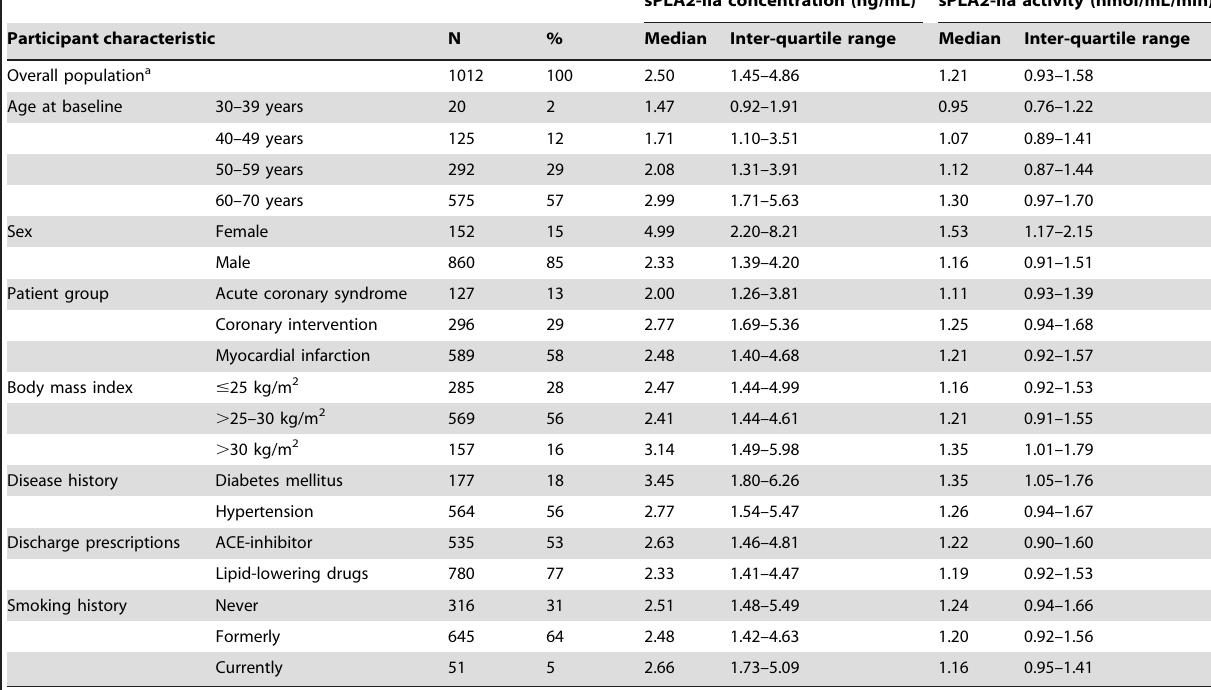
Table 1. Baseline characteristics and sPLA2-IIa concentrations and activities in patients with stable coronary heart